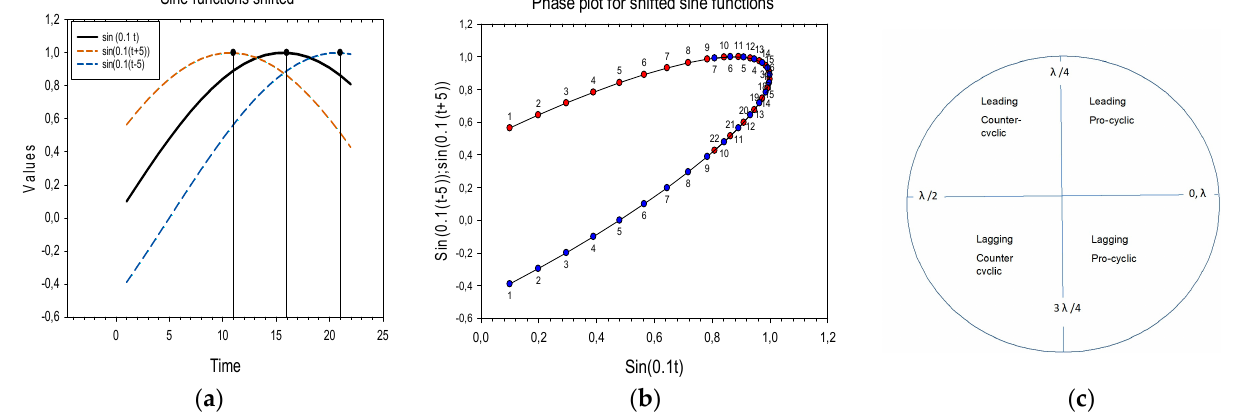
Phase plot for shifted sine functions